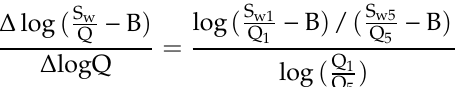
Figure 5. Diagnostic plots and proper equations for well-loss coefficients [1,16]